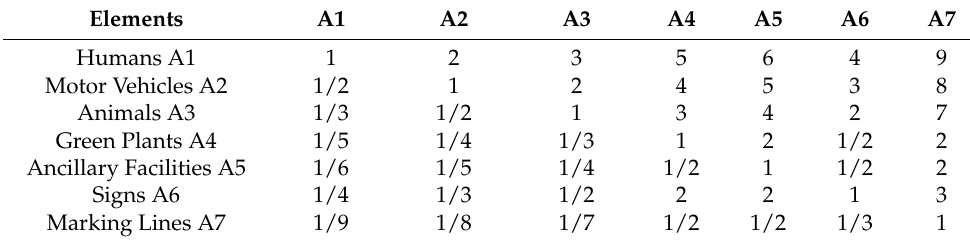
Table 1. Judgment